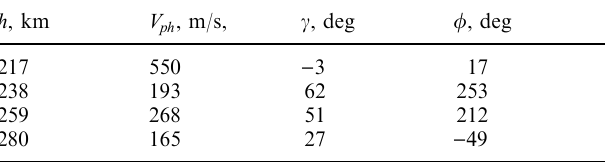
Fig. 4. Intensity of the disturbance in the filtered spectral band 90 min–130 min for the three observing positions and across F -region altitudes indicates intensification of the dis- turbances at altitudes <300 km at the times of sunset and sunrise terminator passage